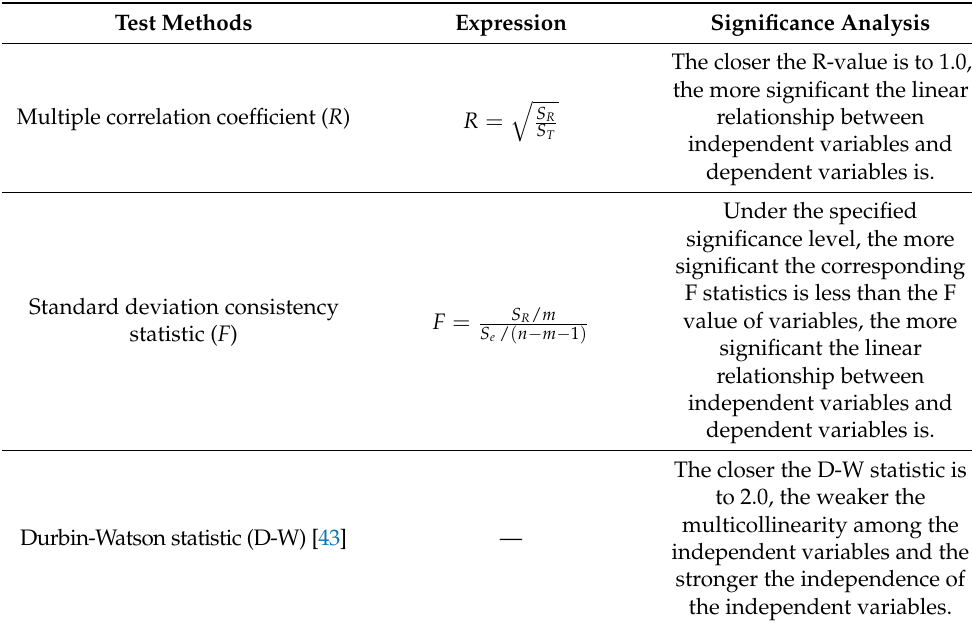
Table 2. Significance test